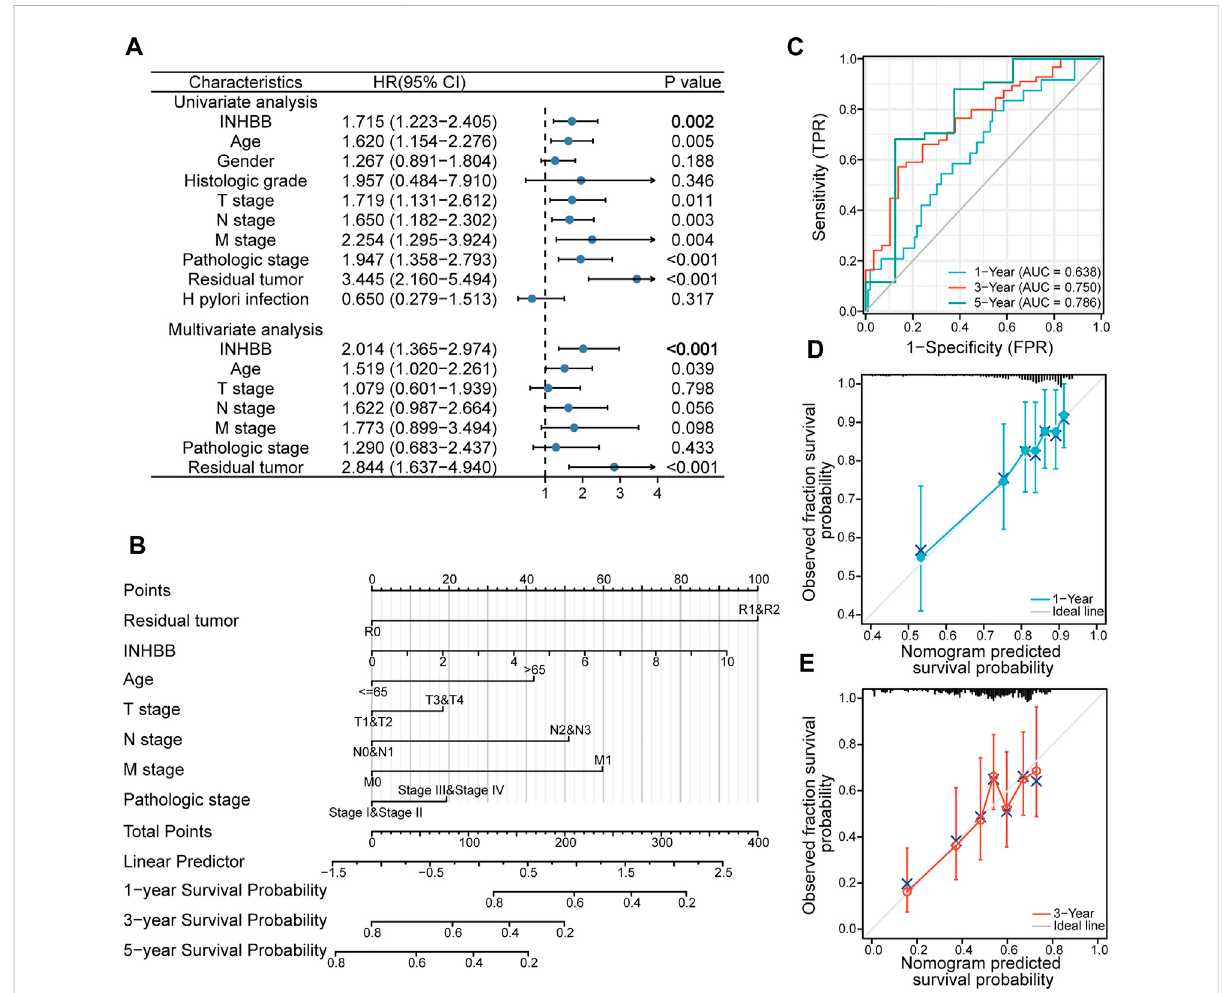
FIGURE 4 ClinicalriskpredictionmodelsofINHBBinGC. (A) CoxregressionanalysisofINHBBinGCpatientdatafromTCGA, (B) nomogrammodelbased on Cox regression analysis, (C) Time-dependent analysis of ROC curve to evaluate nomogram performance, (D,E) 1-year and 3-year nomogram calibration